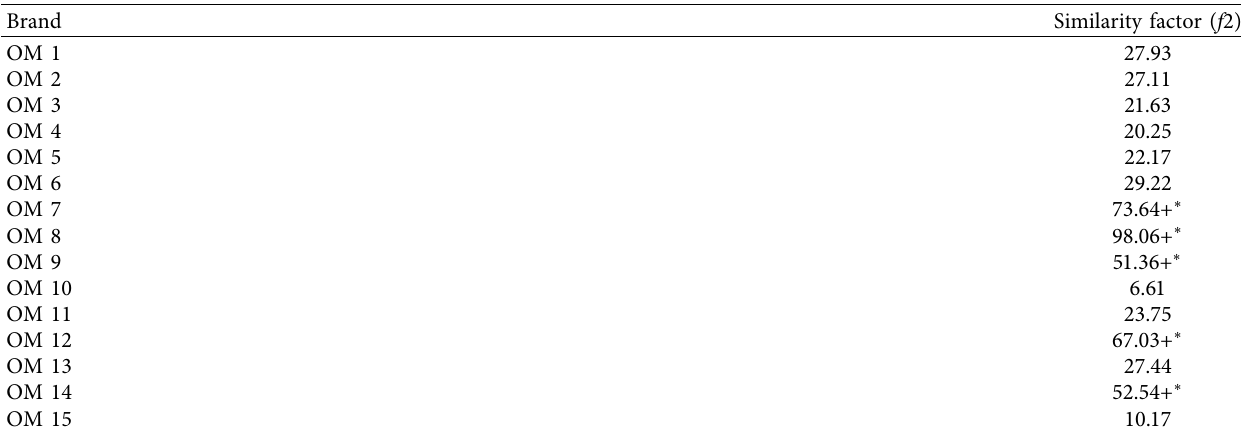
Figure 2: (a) Dissolution profles of OM1, OM2, OM3, and OM4, (b) dissolution profles of OM5, OM6, OM7, and OM, (c) dissolution profles of OM9, OM10, OM11, and OM, and (d) dissolution profles of OM13, OM14, OM15, and OM1. Table 4: Similarity factor for sampled